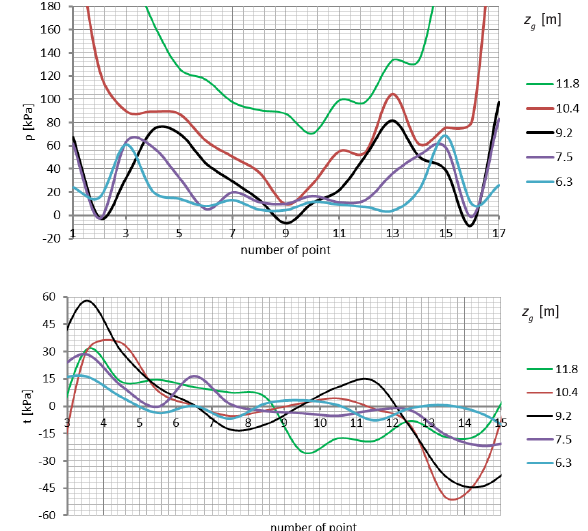
Figure 6: Plots of interfacial interactions along perimeter zone of